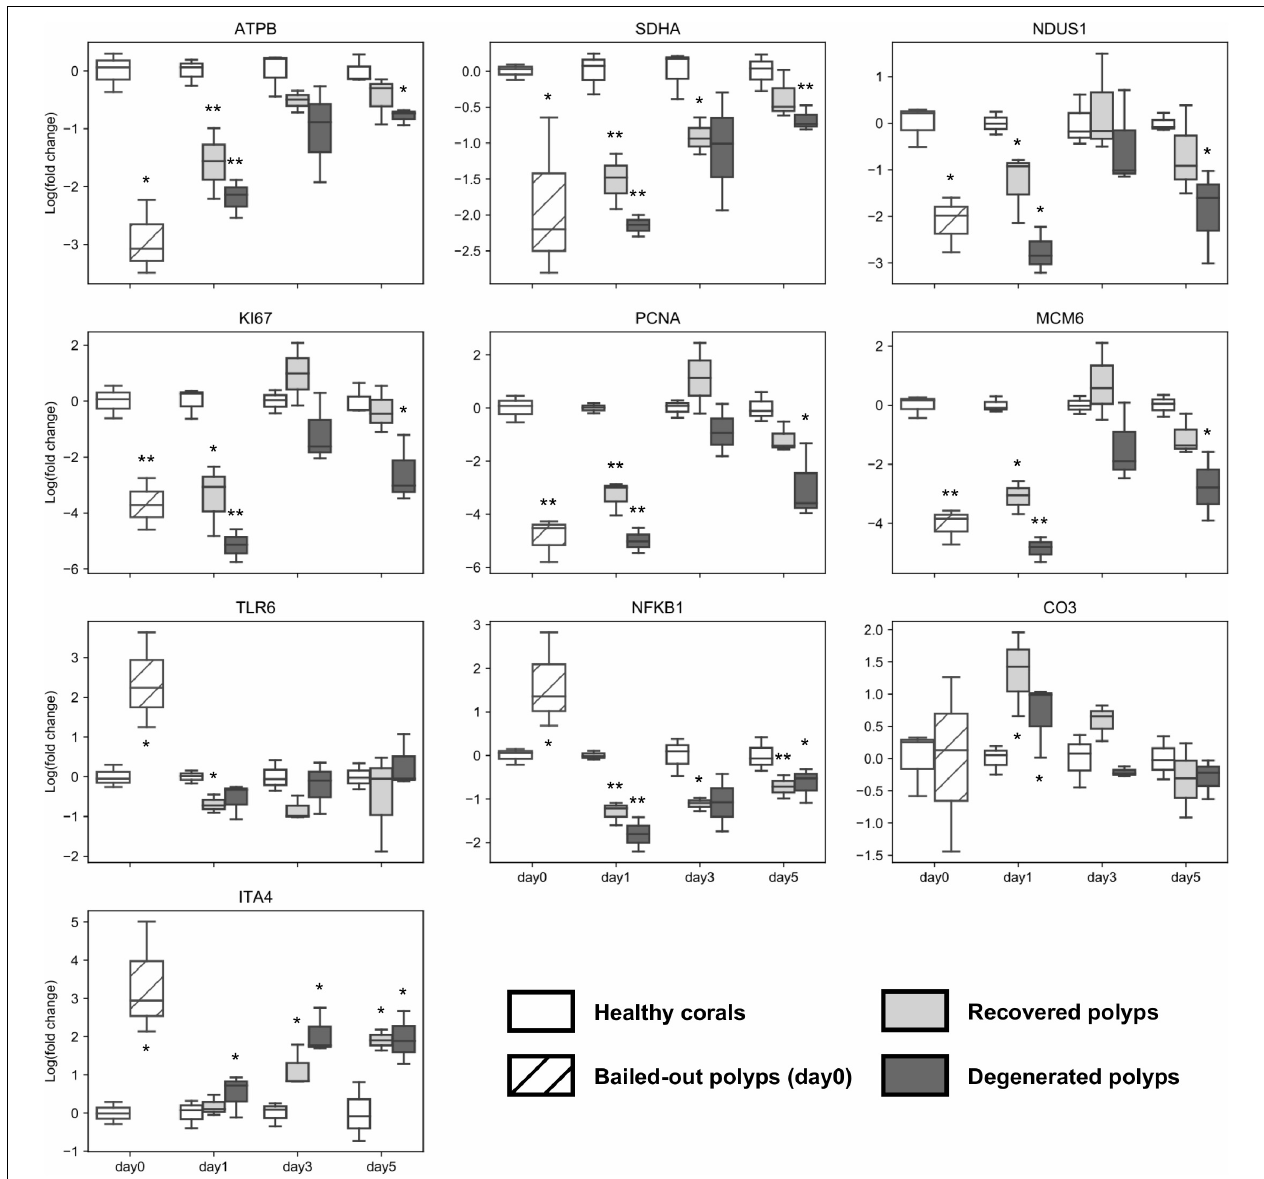
FIGURE 7 | Post-bail-out expression dynamics of ten selected genes. Gene expression is normalized to an internal control gene (Tubulin beta chain) and to mean expression levels of healthy corals at each given time point. Statistical differences between bailed-out polyps and healthy corals at each time point were examined using paired t -tests. Groups showing significant differences compared to healthy corals are indicated (* p < 0.075; ** p < 0.01). Gene name abbreviations: ATPB, ATP synthase subunit beta; SDHA, Succinate dehydrogenase flavoprotein subunit; NDUS1, NADH-ubiquinone oxidoreductase 75 kDa subunit; KI67, Proliferation marker protein Ki-67; PCNA, Proliferating cell nuclear antigen; MCM6, DNA replication licensing factor Mcm6; TLR6, Toll-like receptor 6; NFKB1, Nuclear factor NF-kappa-B p105 subunit; CO3, Complement C3; and ITA4, Integrin